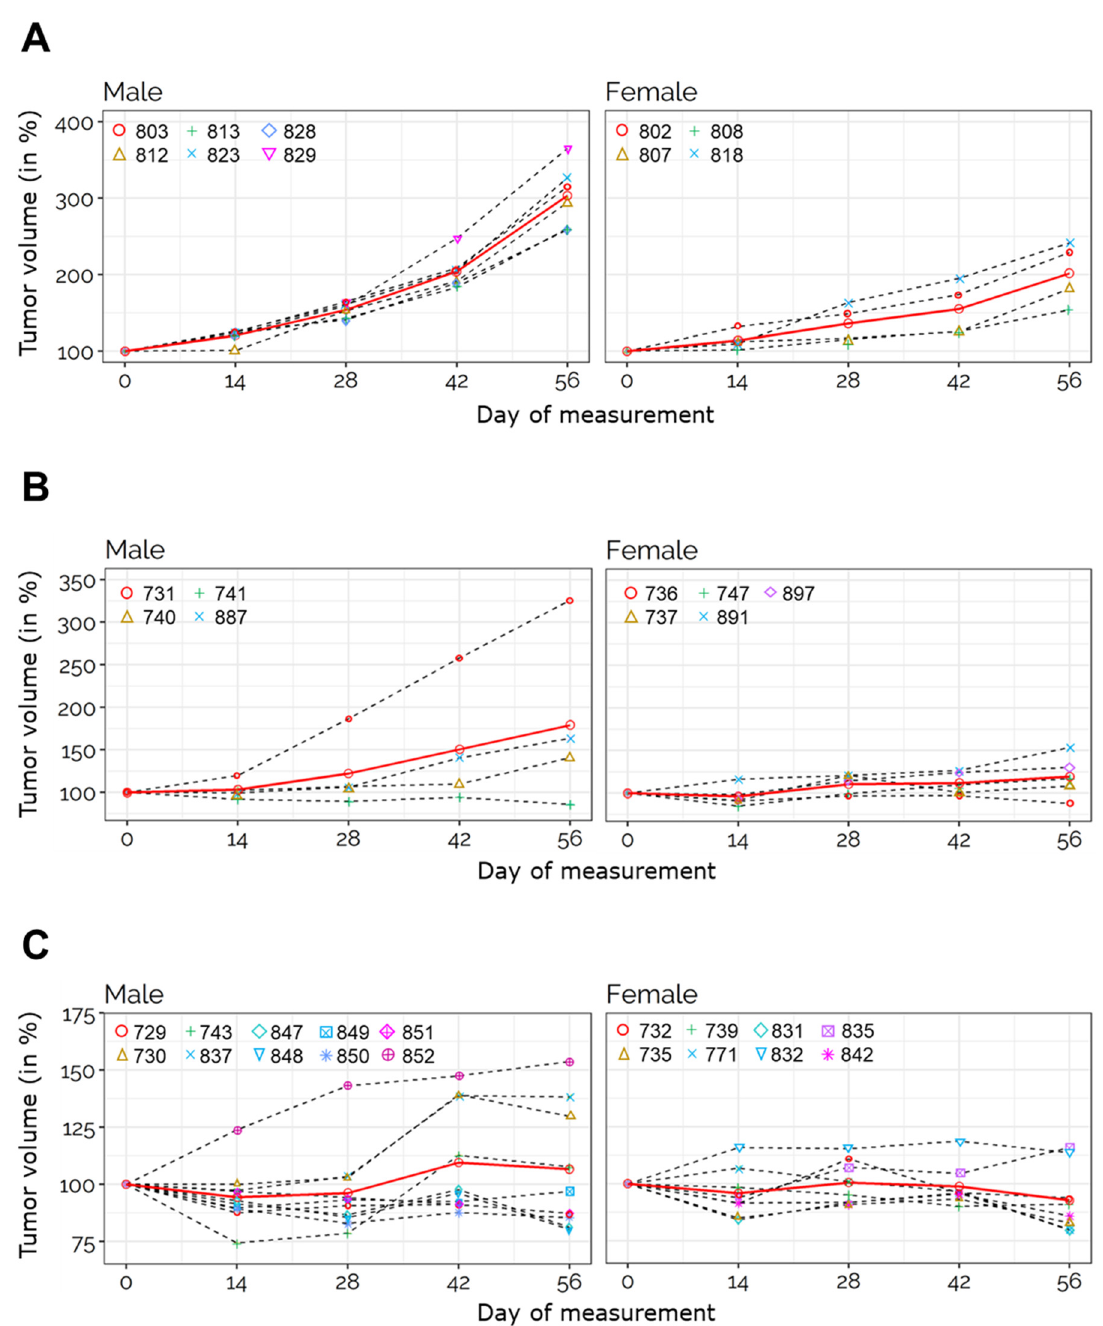
Figure 2. Trace plots of relative tumor volume in the various groups at 56 d post-treatment. Trace plots of tumor volume changes for mutant rats of the different treatment groups relative to the volume at day 0 for each animal. Left, male rats. Right, female rats. ( A ) Trace plot for placebo-treated mutant rats. For statistical analysis an LME model with mean